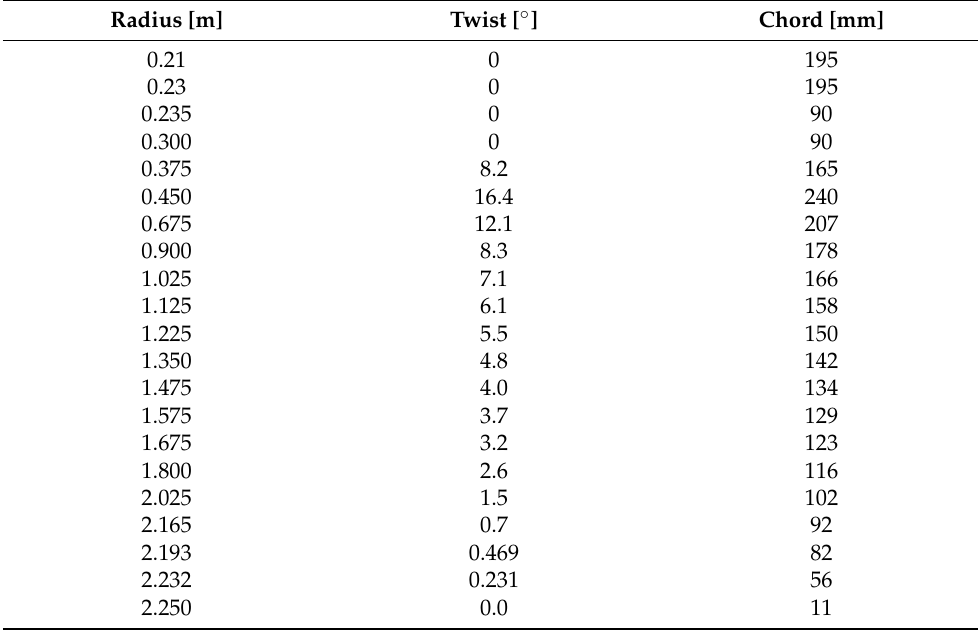
Table 2. Mexico rotor blade twist and chord